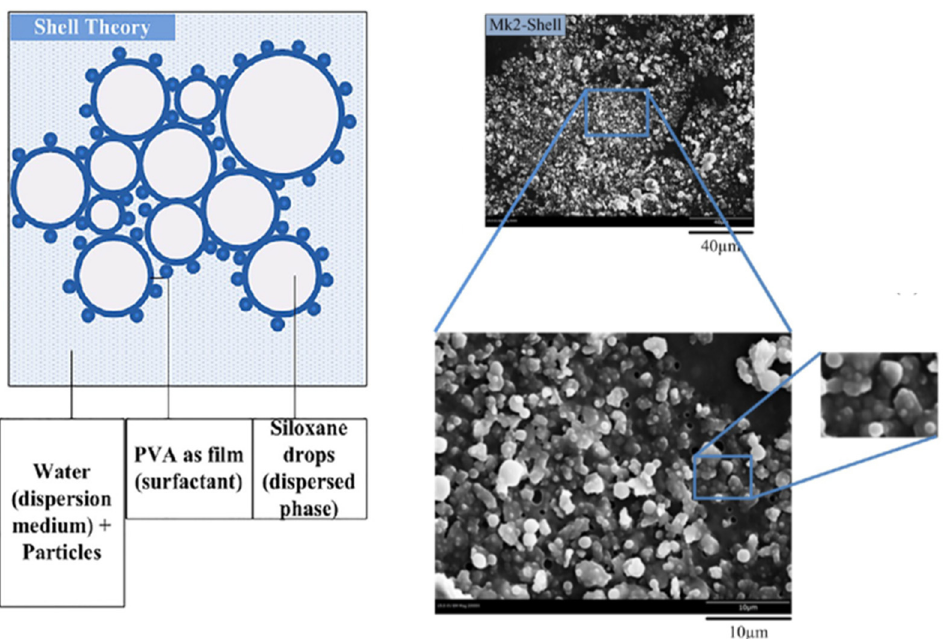
Figure 6. Shell scheme utilized to design a type of polymethylhydroxysilane (PMHS) emulsions in Flores-Vivian et al. [31] with the corresponding SEM images at a different magnification of the resulting coating. PVA, polyvinylalcohol.